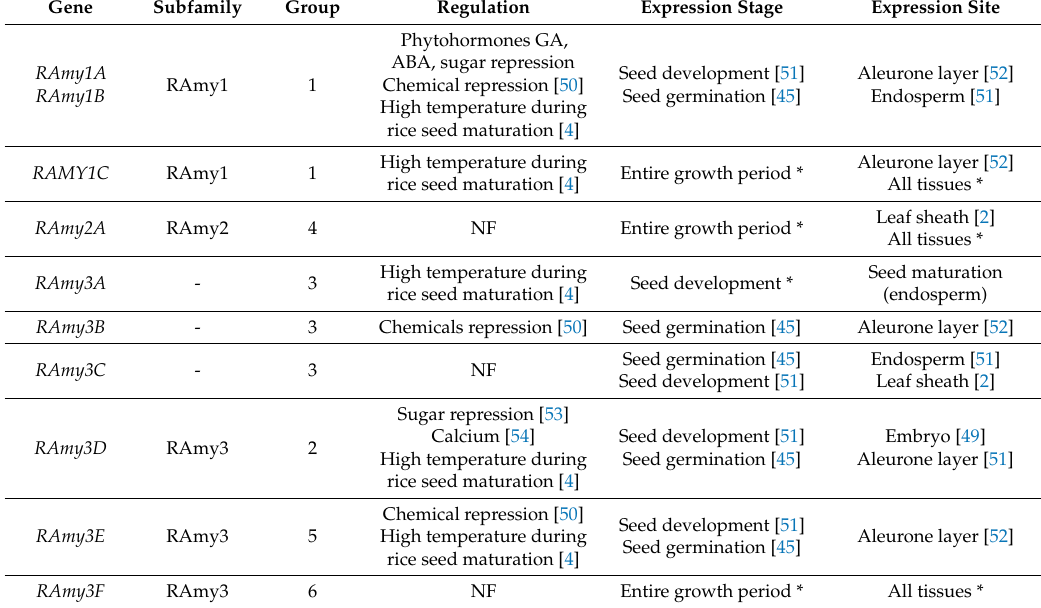
Table 1. Alpha-amylases and their corresponding group and subfamily